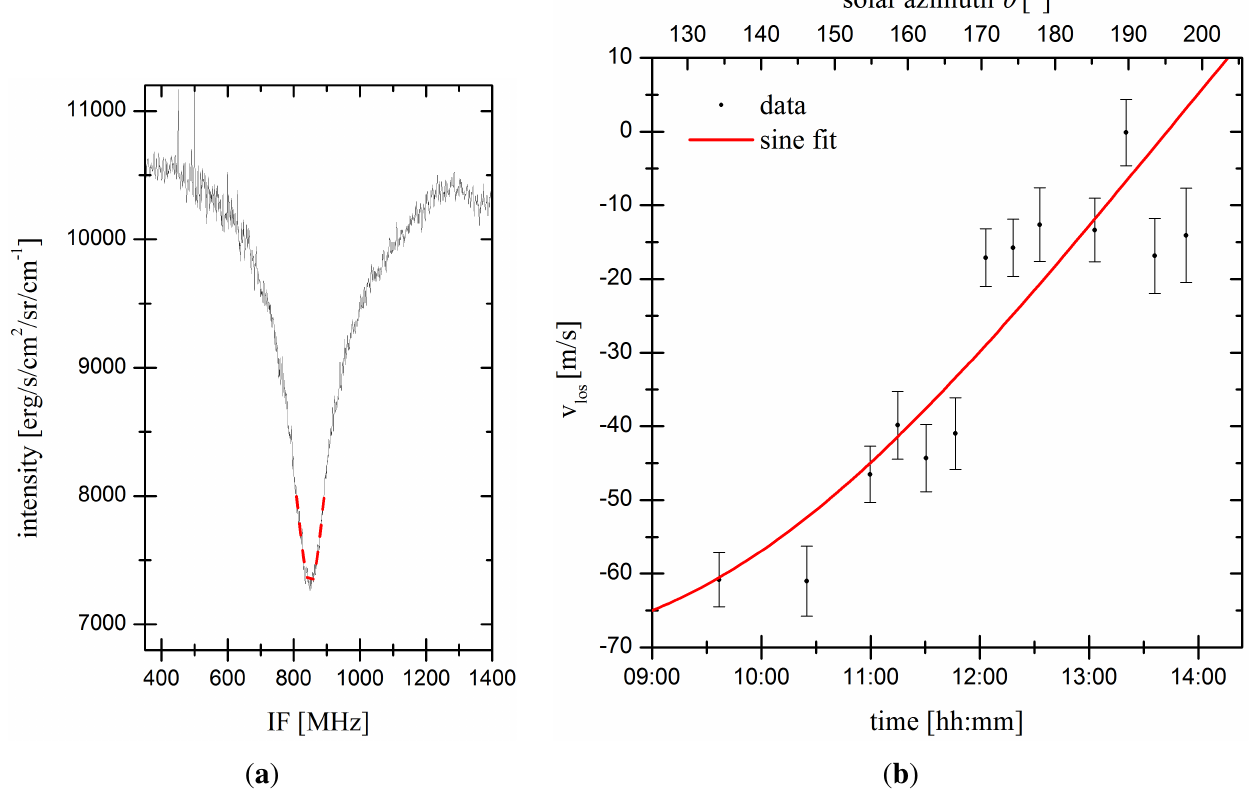
Figure 8. Measured O Line and Line of Sight Wind Velocity. ( a ) One example of a 3 measured O absorption line at an IF of 849.6 MHz (black) and the Voigt fit to the line peak 3 (red); ( b ) Resulting line of sight wind velocities from the Doppler shifted peak positions of the absorption line plotted vs . the observing time and corresponding solar azimuth, θ . The fit error is represented by the error bars. A sine function with a period of 24 h was fitted to the